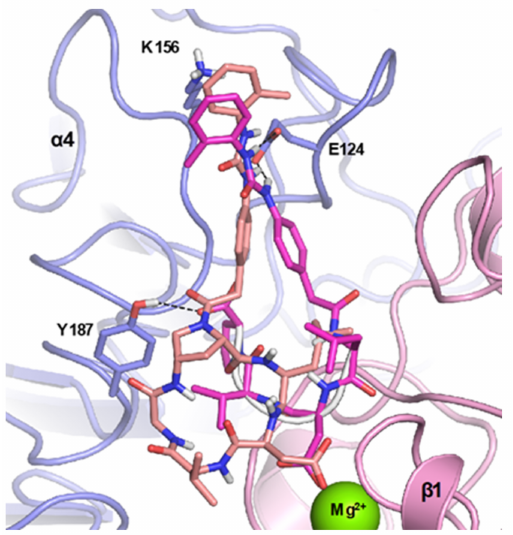
Figure 6. Binding poses of Amp-cyclopeptide 12 (pink sticks) and BIO1211 (purple sticks) in the binding site of α 4 β 1 integrin ( α 4 subunit blue ribbon; β 1 subunit pink